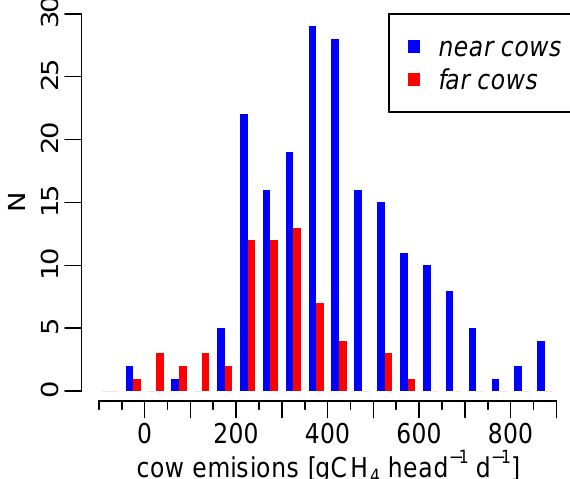
Figure 11. Monthly aggregated distribution of (a) energy-corrected daily milk yield (ECM) of the individual cows in the herd, and (b) cow methane emissions as observed in this study ( near cows cases) and modeled as a function of ECM and cow body weight ( m ) according to 10 + 4 . 9 · ECM + 1 . 5 · m 0 . 75 (Kirchgessner et al., 1995) and (50 + 0 . 01 · ECM · 365 )/ 365 · 100 (Corré, 2002). Crosses indi- cate mean values, boxes represent interquartile ranges, and whiskers cover the full data range.